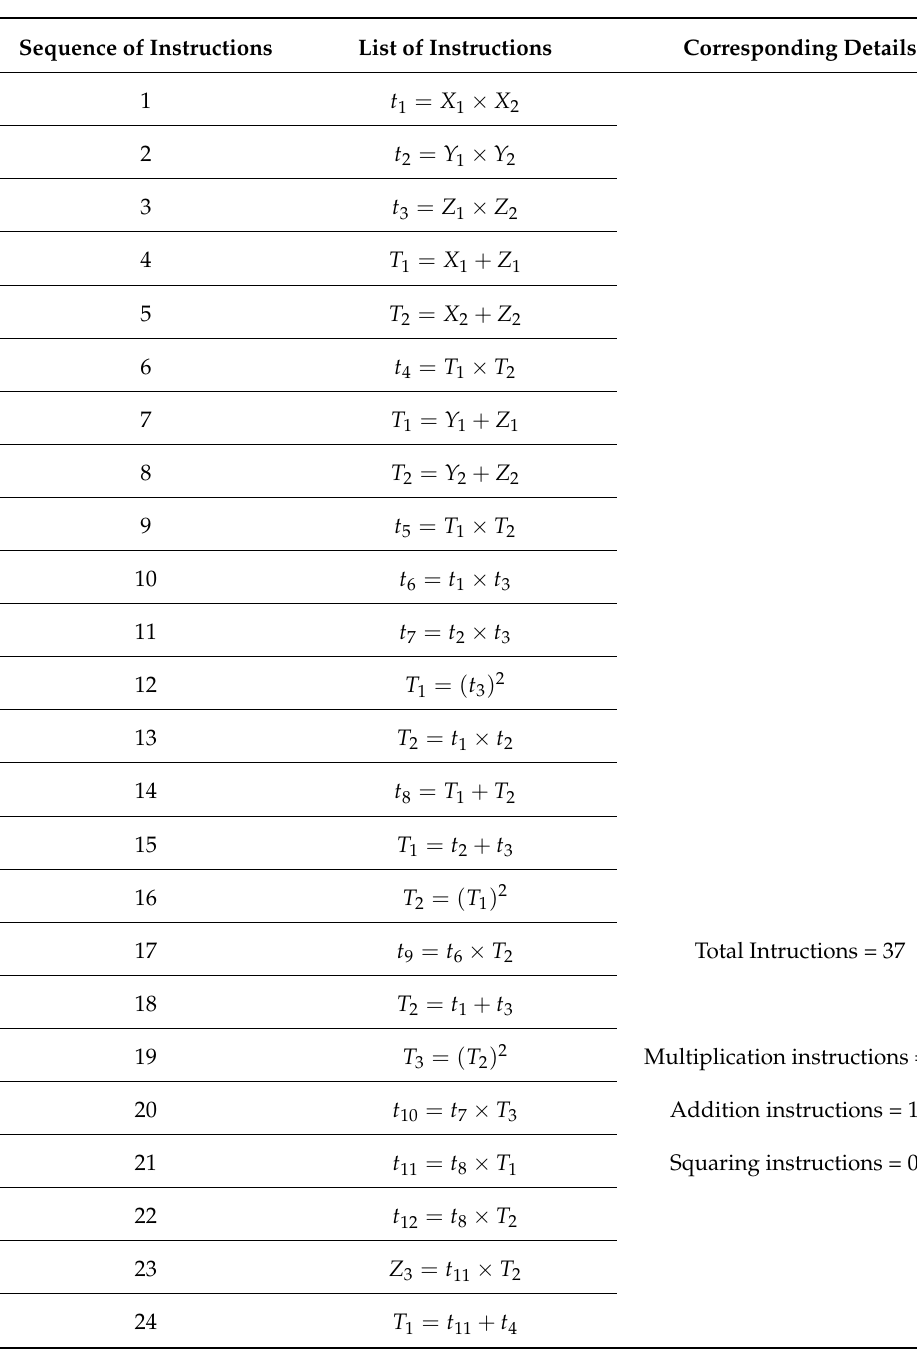
Table 2. Unified addition law of 2018 (shown in column three of Table 1) according to singular adder, multiplier and